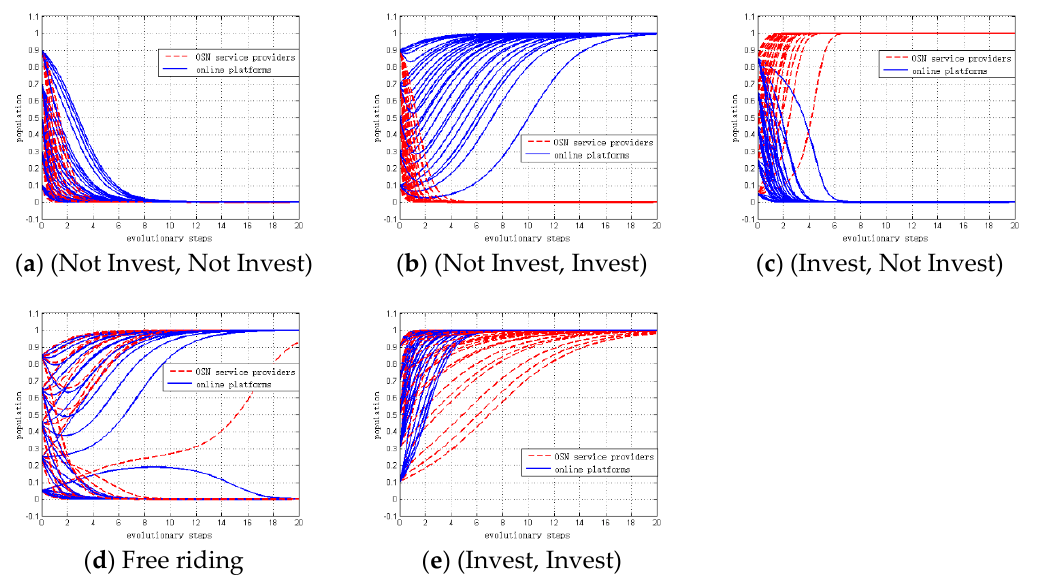
Figure 2. Simulation results of the basic evolutionary model.